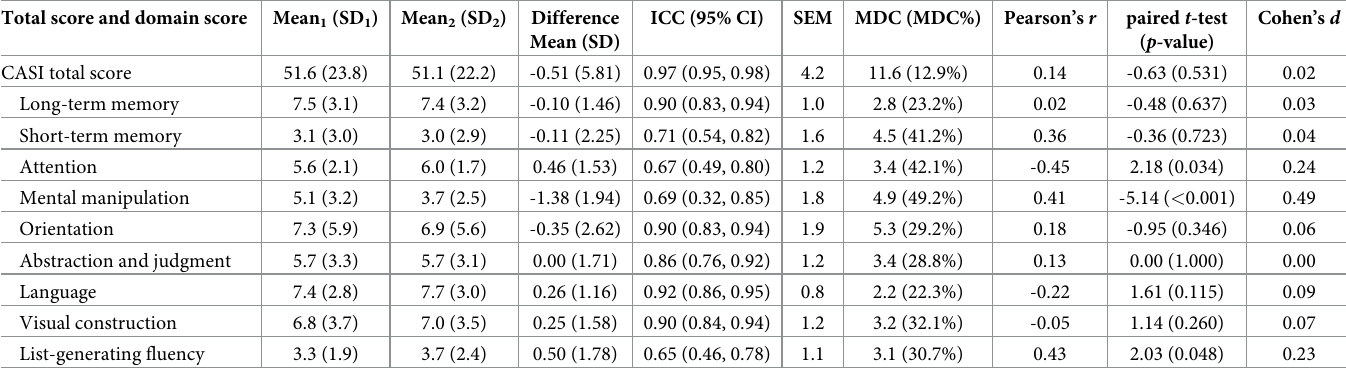
Table 2. Results of reliability in the